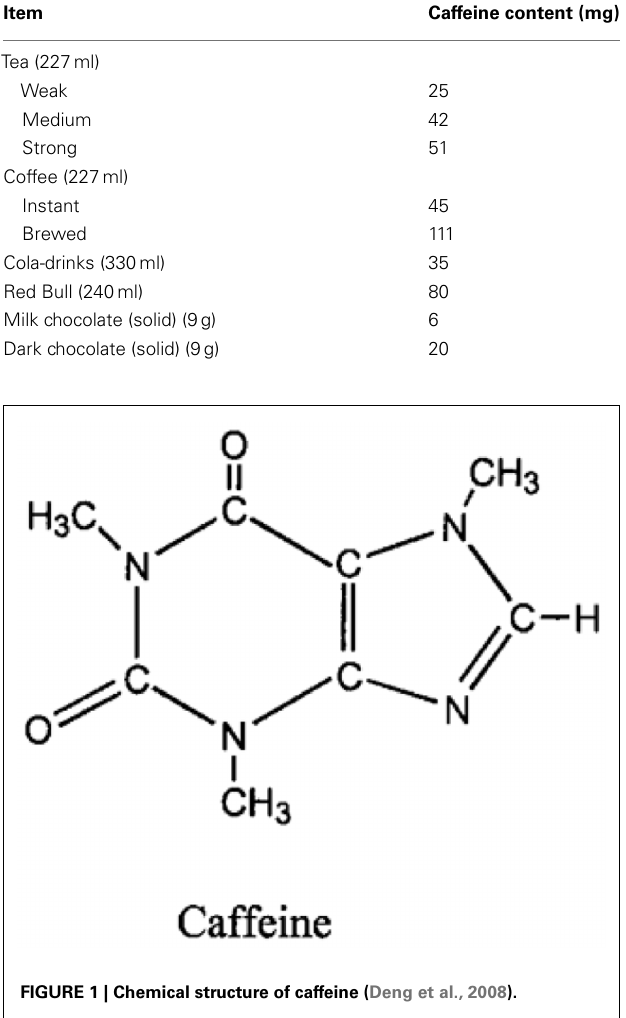
Table 1 |Types of food and drink caffeine content (Jones and Fernyhough, 2008).